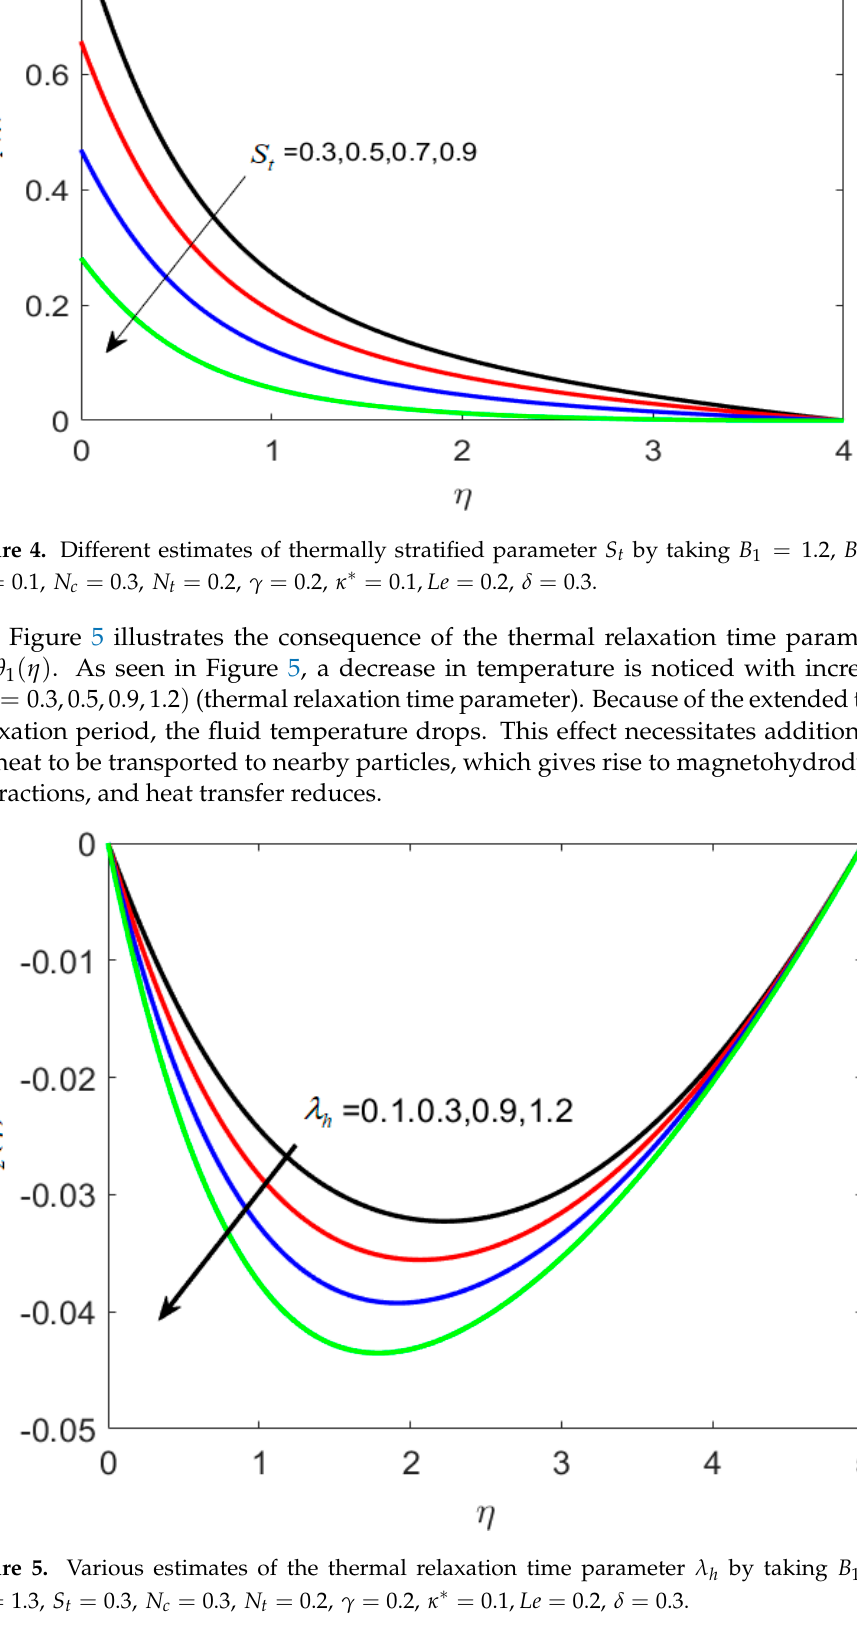
Figure 5. Various estimates of the thermal relaxation time parameter λ h by taking B 1 = 1.2, B 2 = 1.3, S t = 0.3, N c = 0.3, N t = 0.2, γ = 0.2, κ ∗ = 0.1, Le = 0.2, δ =